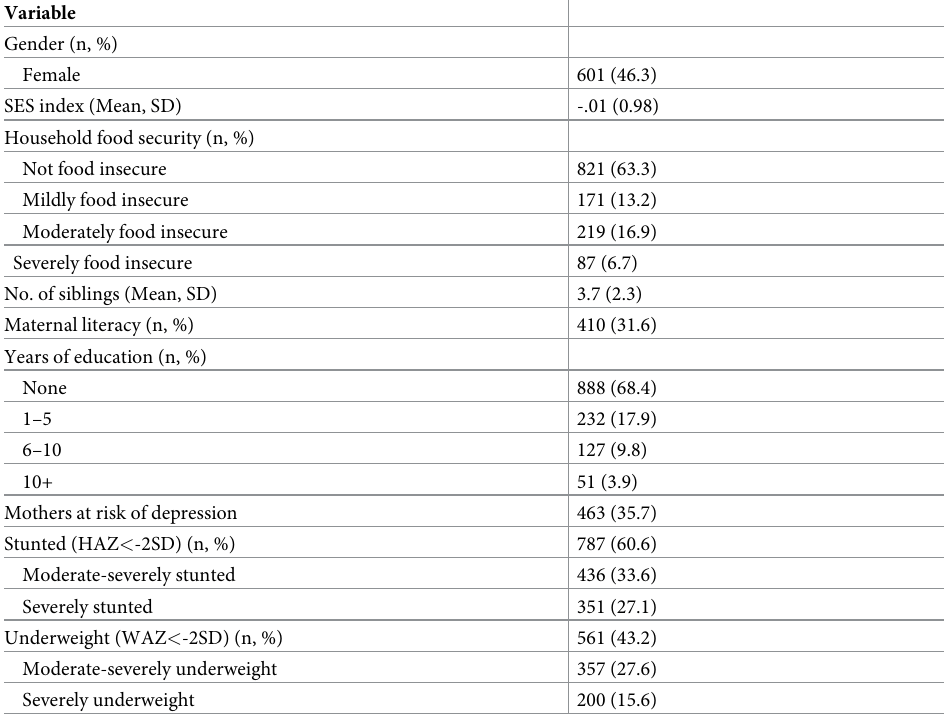
Table 1. Sociodemographic characteristics of the cohort at 2 years (N =